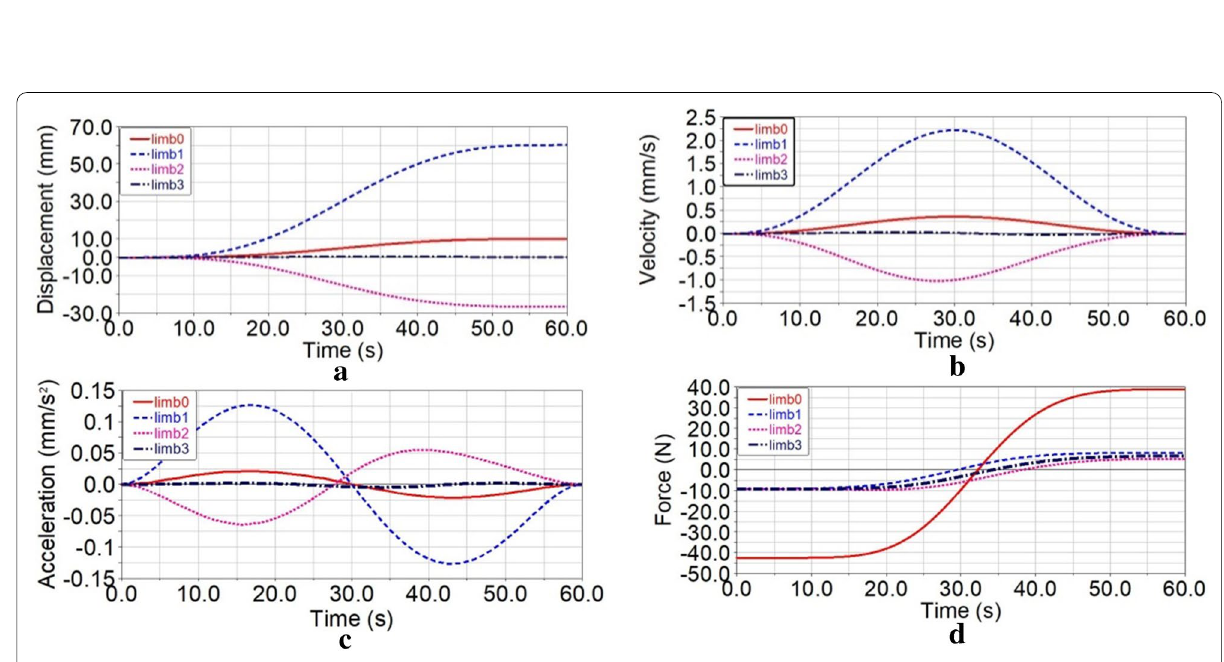
Figure 13 a Displacement, b velocity, c acceleration, and d driving force of each limb of module 6